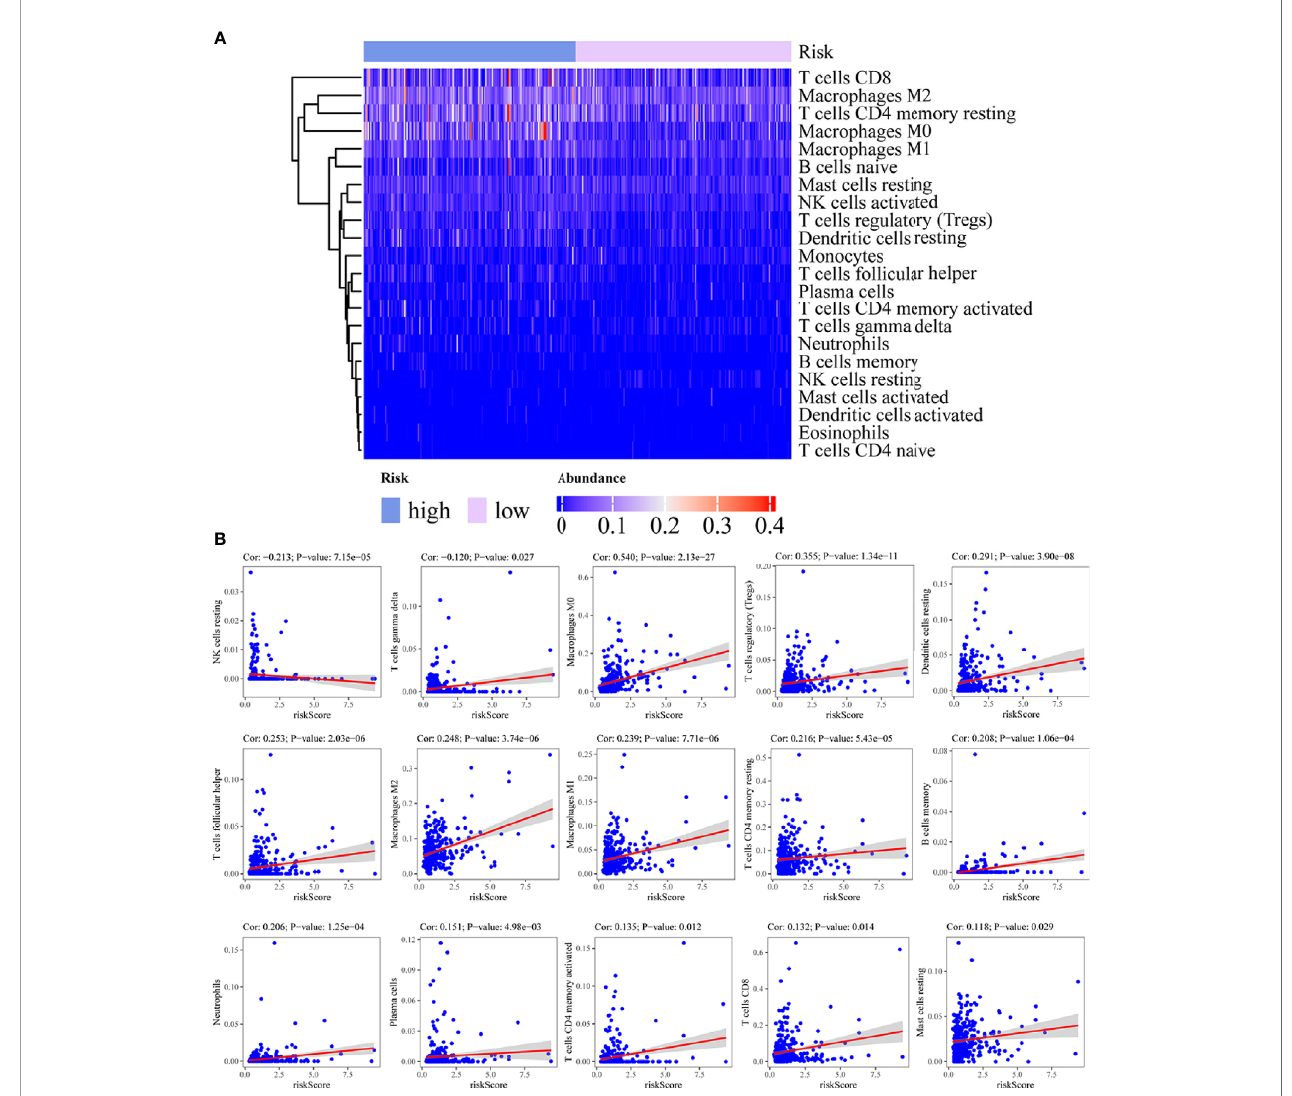
FIGURE 6 | Correlation between the immune-related lncRNA signature and 22 immune cell in fi ltration using CIBERSORT. (A) The heatmap showed the 22 TIICs abundance in high-risk groups and low-risk groups. (B) Correlation between immune cell in fi ltration and this immune-related lncRNA